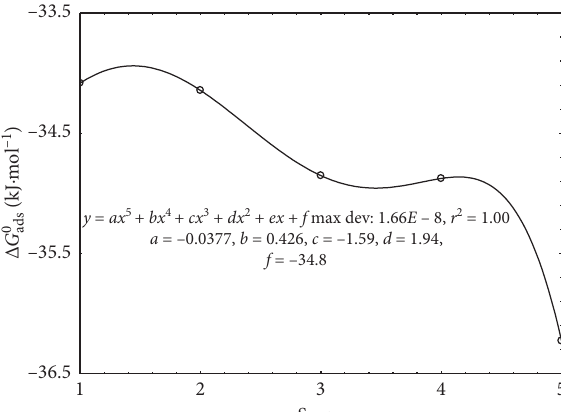
Figure 12: Variation of Δ G o